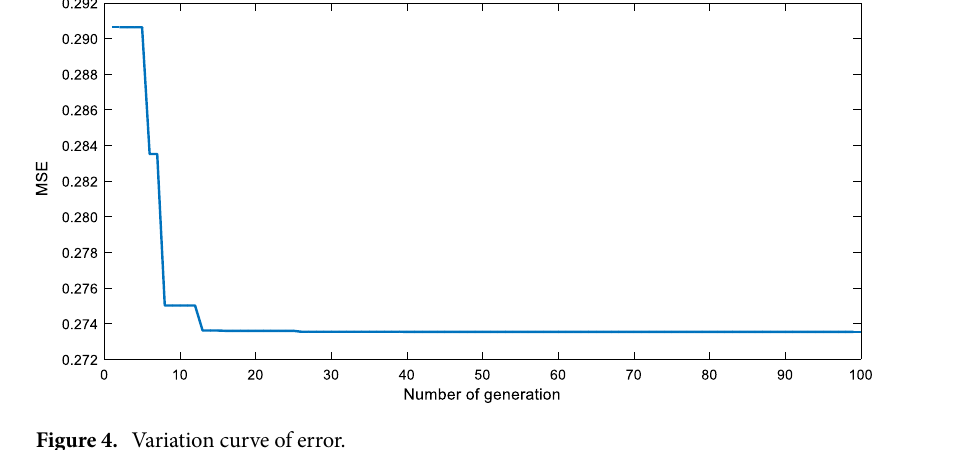
Figure 4. Variation curve of error.